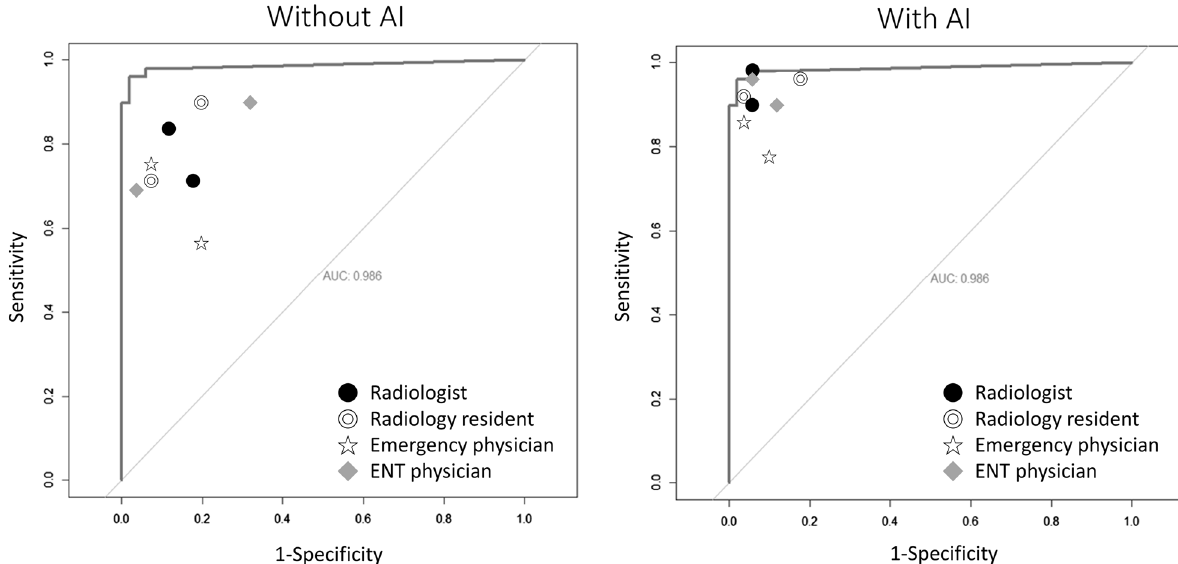
Fig. 3 Physicians’ performances with and without AI assistance. ROC curve showing the performance of each physician with and without AI assistance. The two readings were separated with a washout period of 6 months